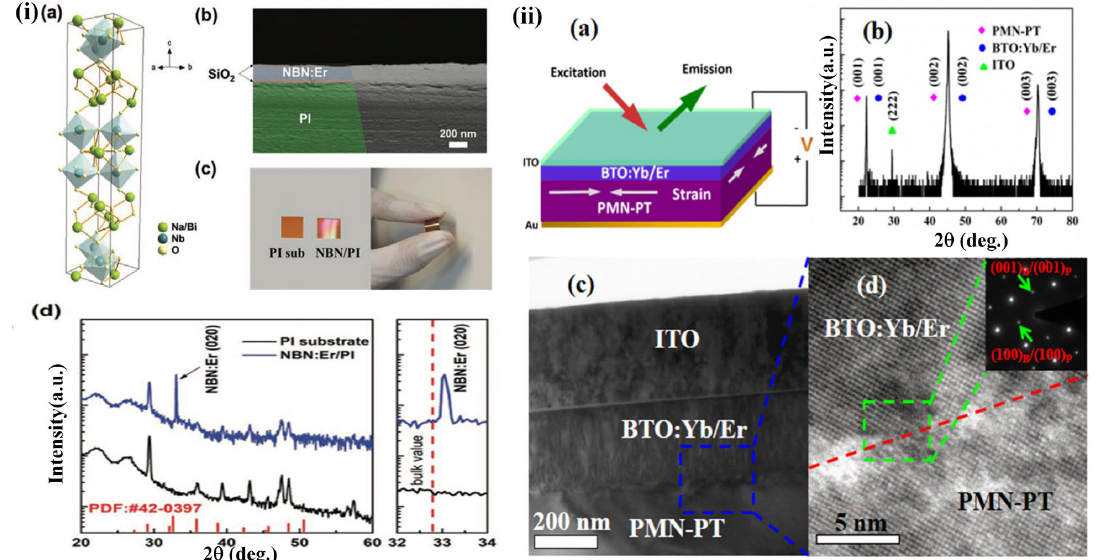
Figure 6. (i) ( a ) Schematic diagram of NBN unit cell crystal structure. ( b ) FE-SEM image of cross- section of NBN: Er/PI sample. ( c ) PI substrate (1 × 1 cm 2 ), optical images of NBN: Er/PI samples in flat and curved states. ( d ) Left: XRD results of PI substrate and NBN: Er/PI sample, right: narrow range of NBN: Er(020) peak θ –2 θ Spectrum. Reprinted with permission from [44] © 2020 Wiley-VCH. (ii) ( a ) (BTO: Yb/Er)/PMN-PT upconversion photoluminescence device under external electric field. ( b )XRD θ -2 θ Pattern. ( c ) A low luminance field image. ( d ) HRTEM image of the interface structure. Insert shows the SAED pattern. Reprinted with permission from [45] © 2014 The Optical Society.